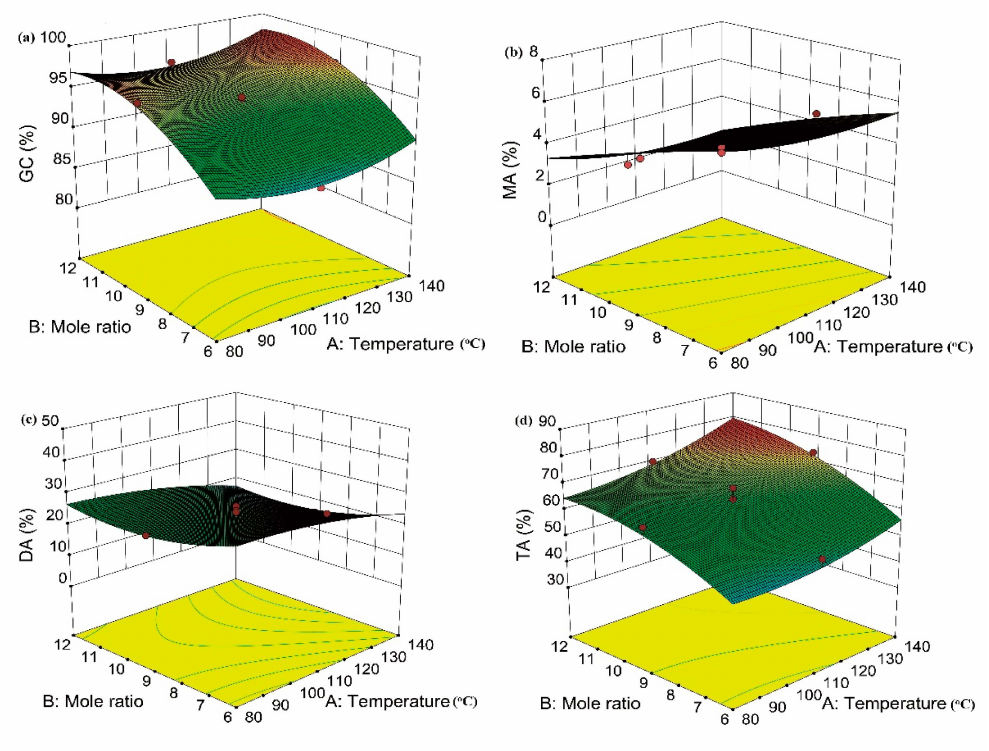
Figure 11. Surface response plots for ( a ) GC and selectivity to ( b ) MA, ( c ) DA, ( d ) TA as a function of the G / AA mole ratio, and temperature at a constant catalyst load (0.6 g) and reaction time (3